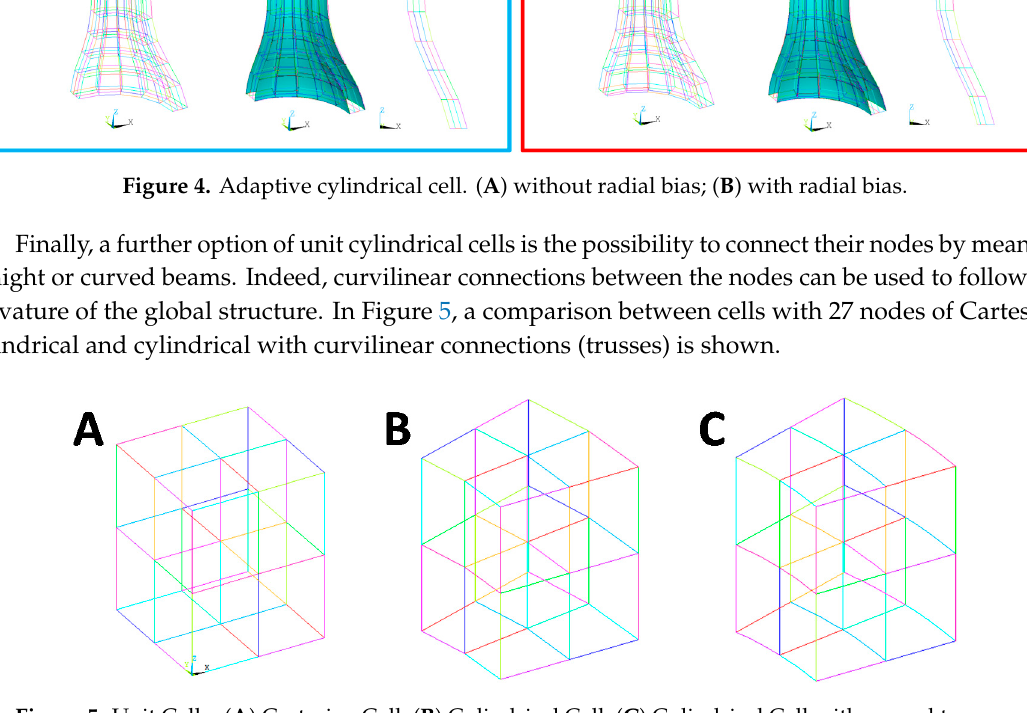
Figure 5. Unit Cells. ( A ) Cartesian Cell; ( B ) Cylindrical Cell; ( C ) Cylindrical Cell with curved trusses.